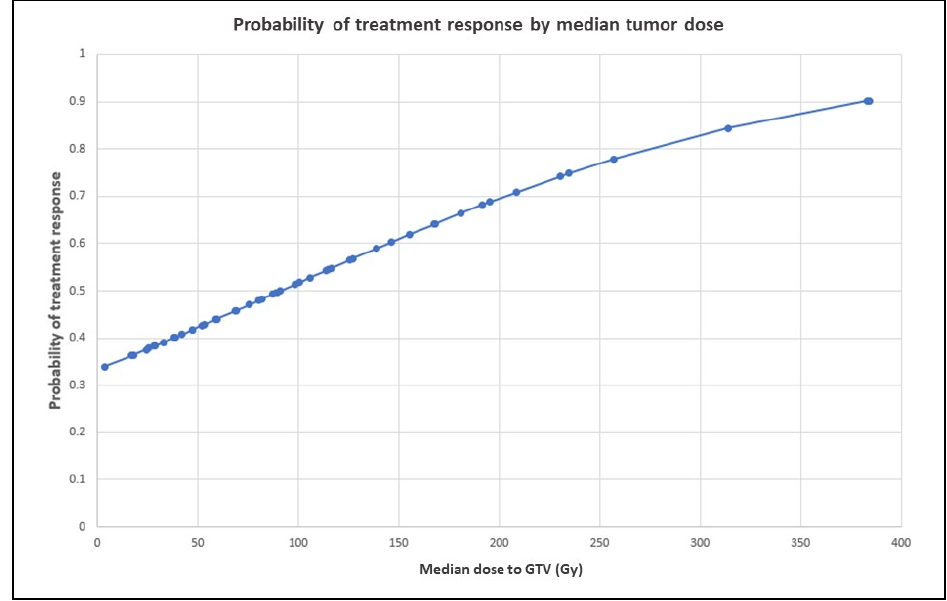
Figure 4. Probability of treatment response by median tumor dose. The graph shows an approxi- mately linear relationship, with 90% tumor response probability at GTV dose > 350 Gy. Probabilities at various levels of the independent variable were derived from logistic regression odds ratios.